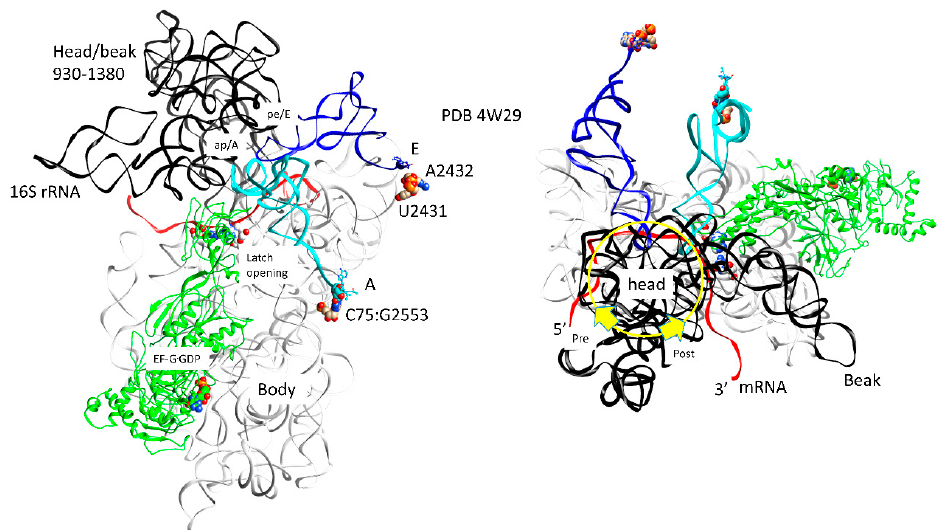
Figure 9. EF-G GTPase activity and translocation. The tRNA pe/E and ap/A (or ap/ap) hybrid states are observed. The 16S rRNA nucleotides 930–1380 are black (head/beak domain). mRNA (red) occupies the channel between the 16S rRNA body and head/beak (the neck). The codon-anticodon latch is not fully closed and the ap/A tRNA anticodon stem loop (ASL) has disengaged from the latch and has begun to translocate toward the P-site. For the ap/A-site tRNA, the 3’-CCA, where a peptide chain would be attached, makes a typical CCA A-site contact (C75:G2553). The pe/E tRNA 3’-CCA makes a typical E-site contact (U2431, A2432). EF-G . GDP is in an extended conformation supporting forward translocation and acting as a pawl to prevent reverse translocation.